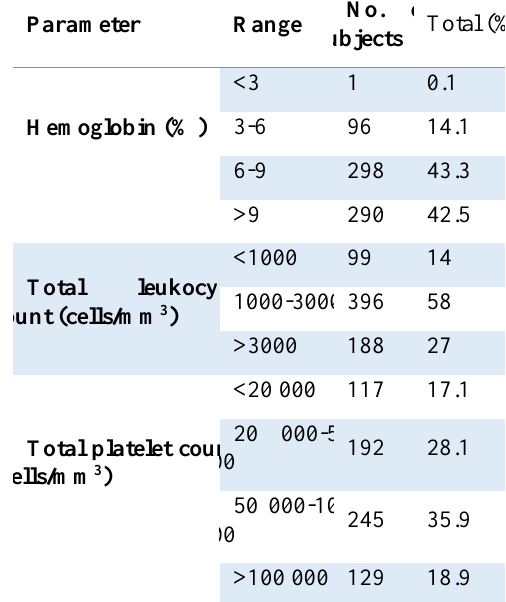
Table 3. The Frequency of Three Haematological Elements in Patients With Pancytopenia